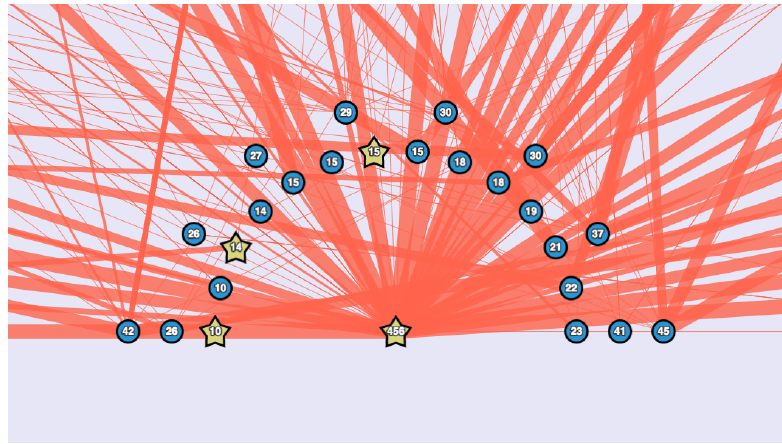
Figure 6. Performance visualization through a concentric layout: bad